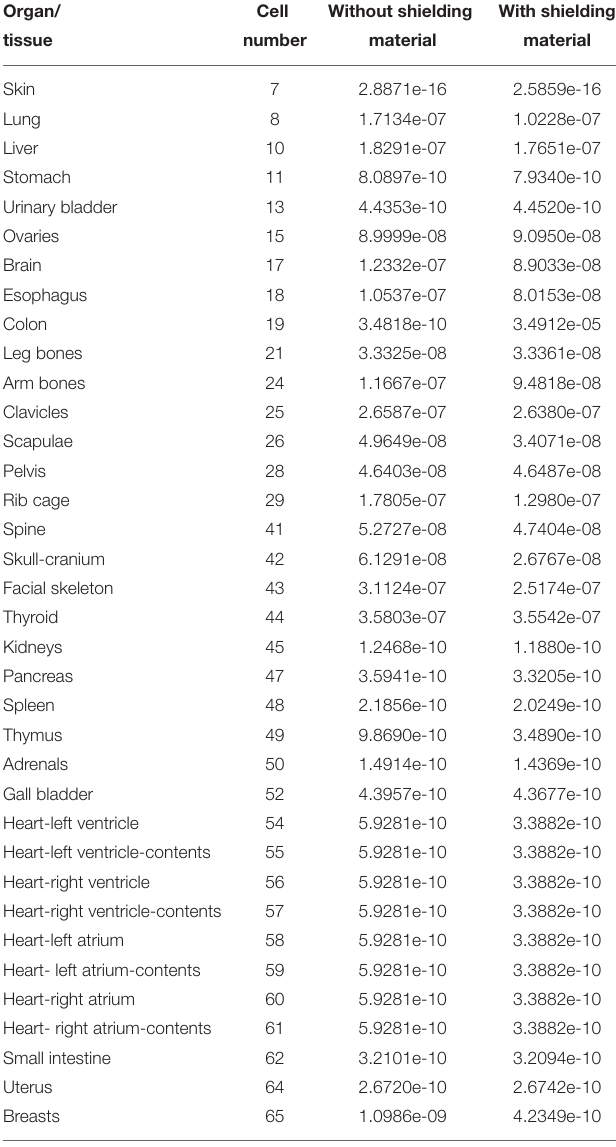
TABLE 1 | Energy depositions (MeV/g per initial photon) of some organs and tissues obtained from MCNPX output (F6 Tally Mesh).